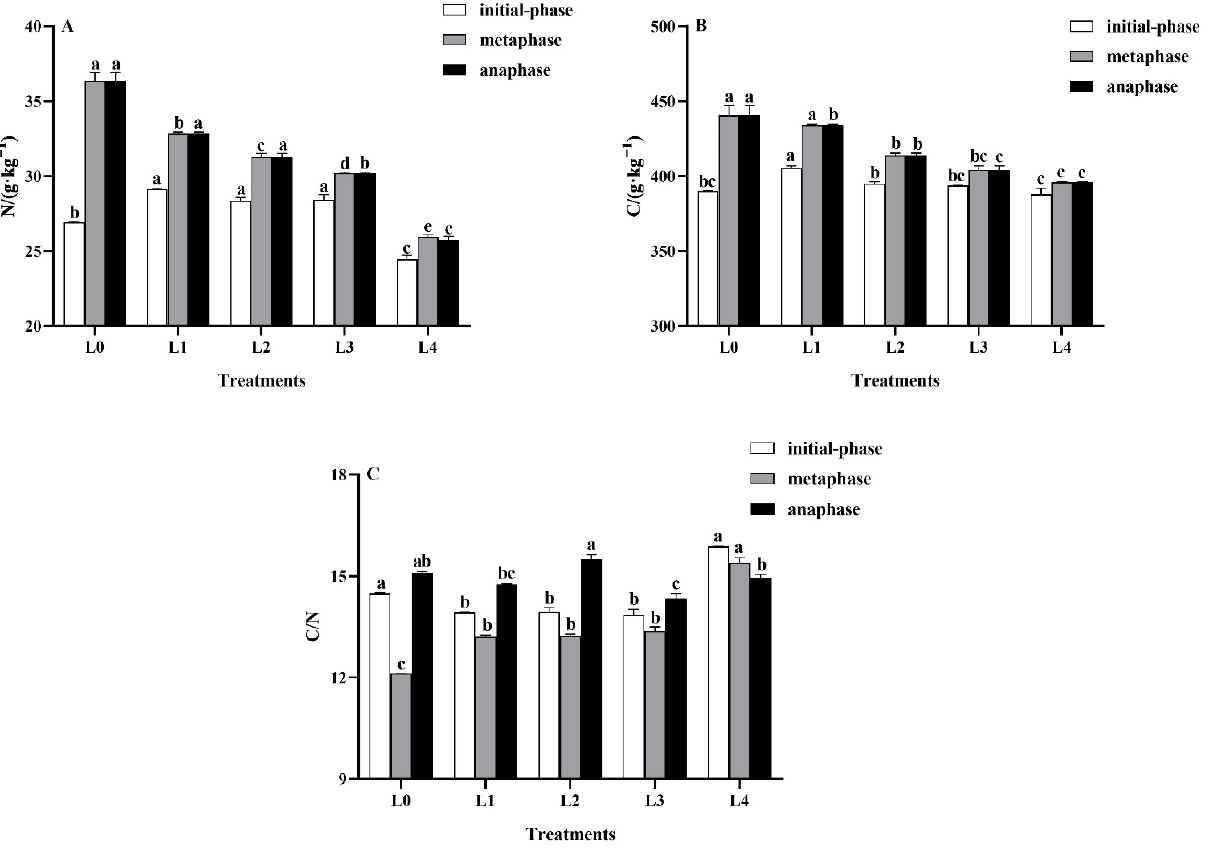
Figure 4. Effects of different light intensities on nitrogen ( A ) and carbon ( B ) production and their ratio ( C ) in Ma bamboo. Note: L0, L1, L2, L3, and L4 refer to 100%, 40%, 30%, 20%, and 10% of natural light, respectively. Values are the means ± SE of four replicates per treatment. Different letters indicate significant differences between treatments at the same shooting period ( p < 0.05).